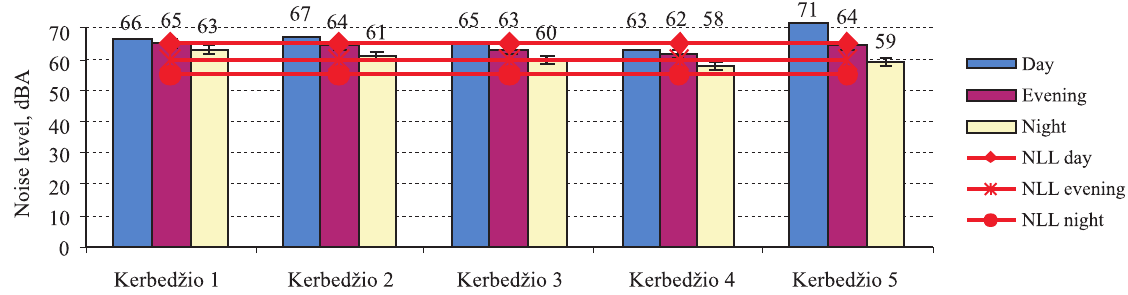
Fig. 3. Change of equal noise levels in S. Kerbedžio street in the course of a day (NLL – noise level